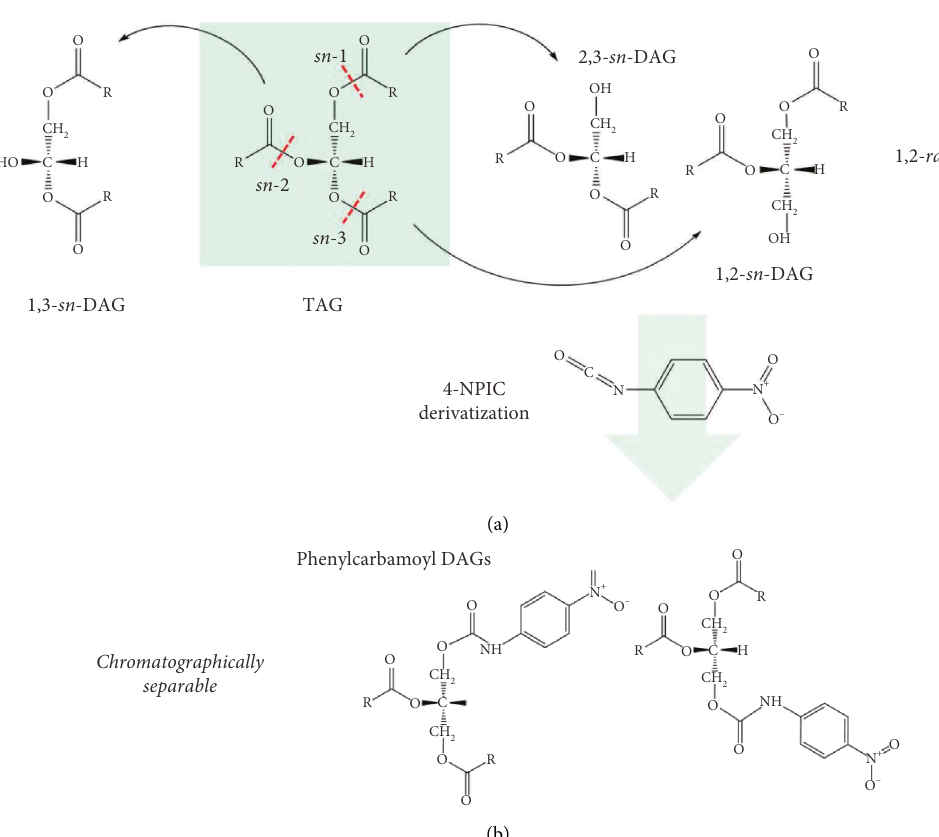
Figure 5: Chromatographic resolution of produced acylglycerol species during lipase catalysis. (a) Chiral status of putative diacylglycerols (DAG) liberated from a prochiral triacylglycerol (TAG) molecule by lipase. (b) Carbamate derivatization of chiral DAGs by using 4- nitrophenyl isocyanate (4-NPIC) for chromatographic